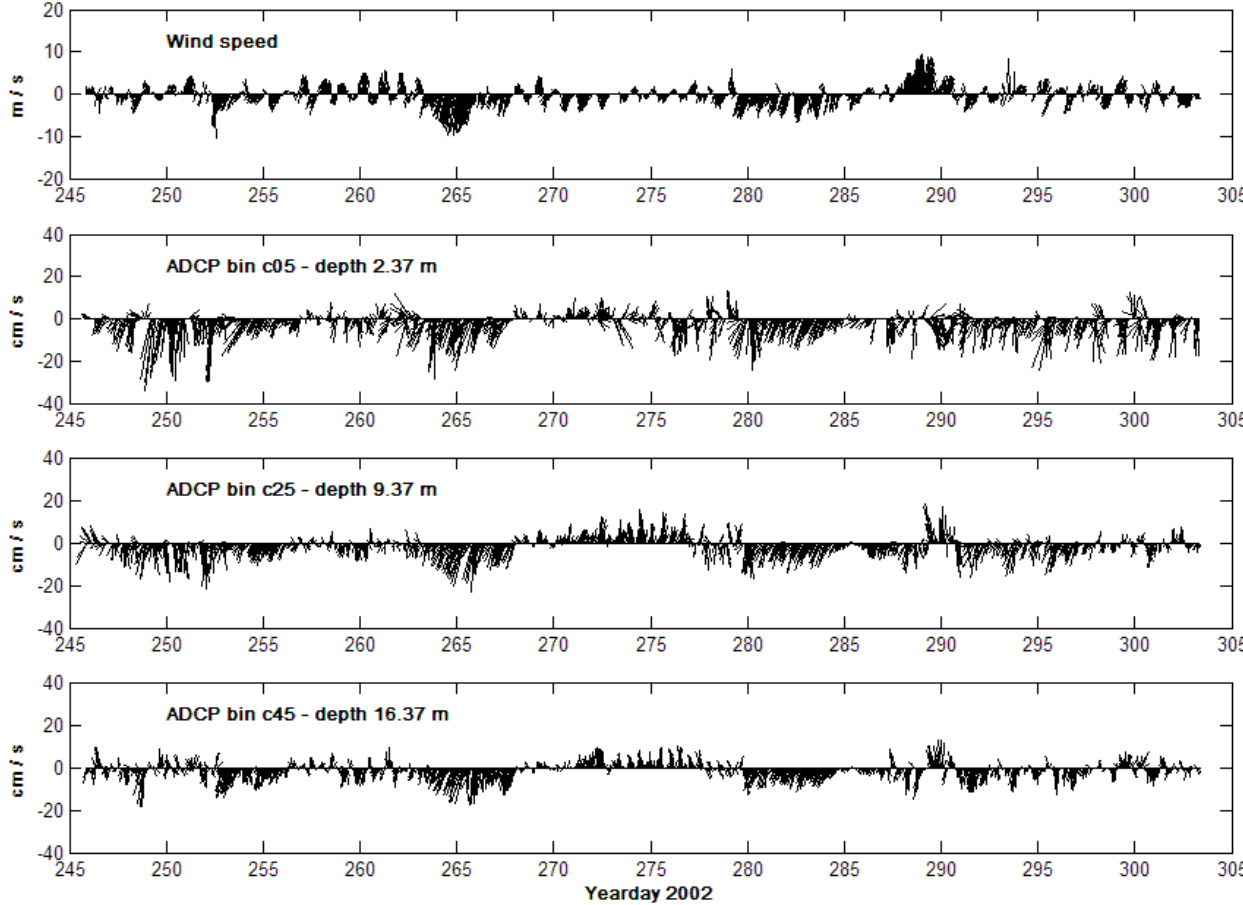
Figure 3. Fig. 3. Time series of wind speed at the oceanographic tower (upper panel) and currents at 2.37m, 9.37m and 16.37m depths. Units are m/s for wind speed, cm/s for